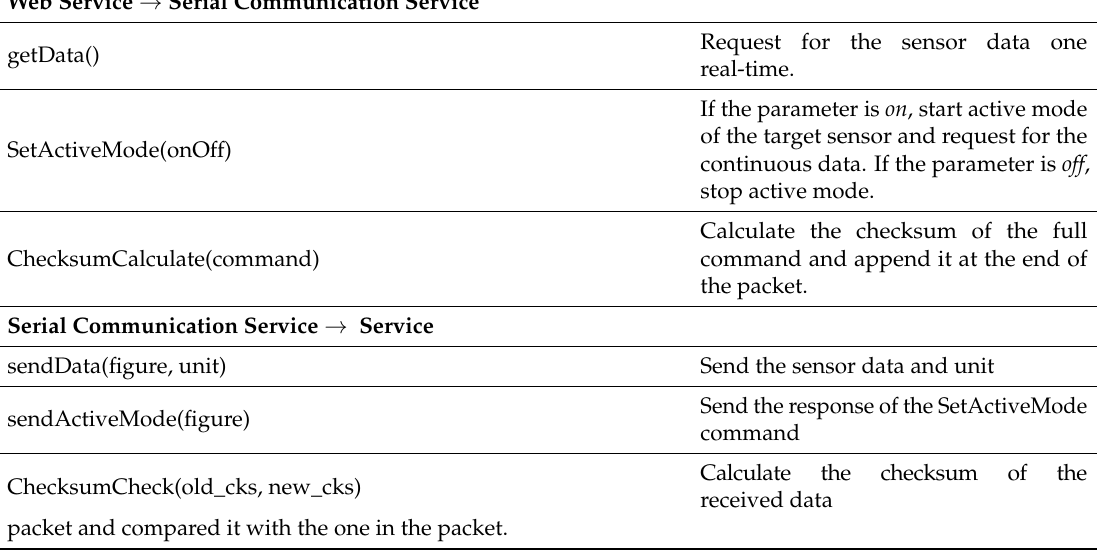
Table 5. Methods implemented for the information exchange between the communication services and their